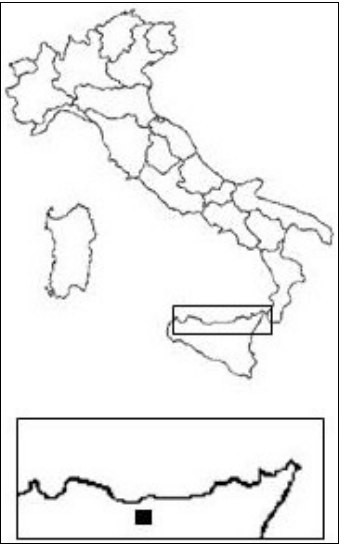
Figure 1. The small black rectangle indicates the Polizzi Generosa village in the Sicily island, where the cultivation of the “Badda” bean is